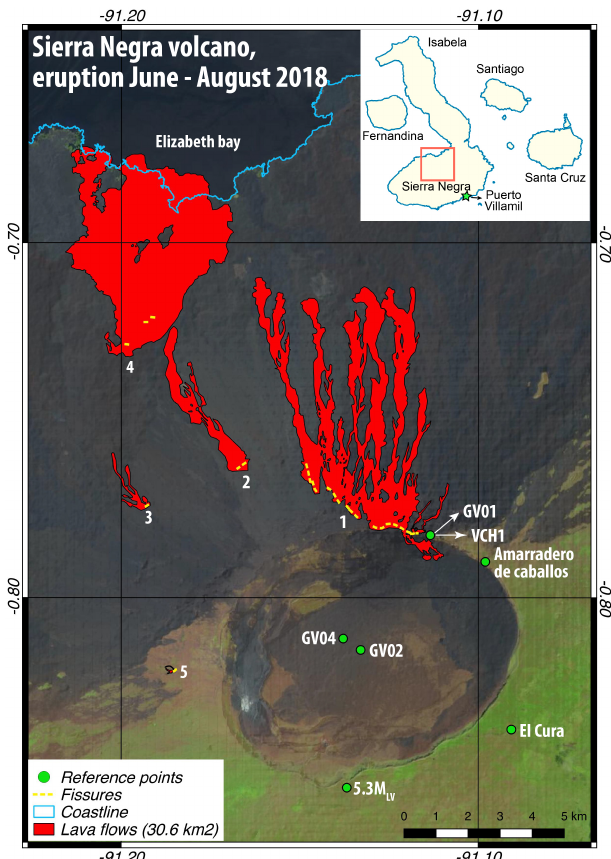
Figure 5: Map of 2018 Sierra Negra eruption (updated until 19 September 2018). Green dots are the main ref- erence locations, which include cGPS and seismic per- manent stations, epicenter of the earthquake M LV